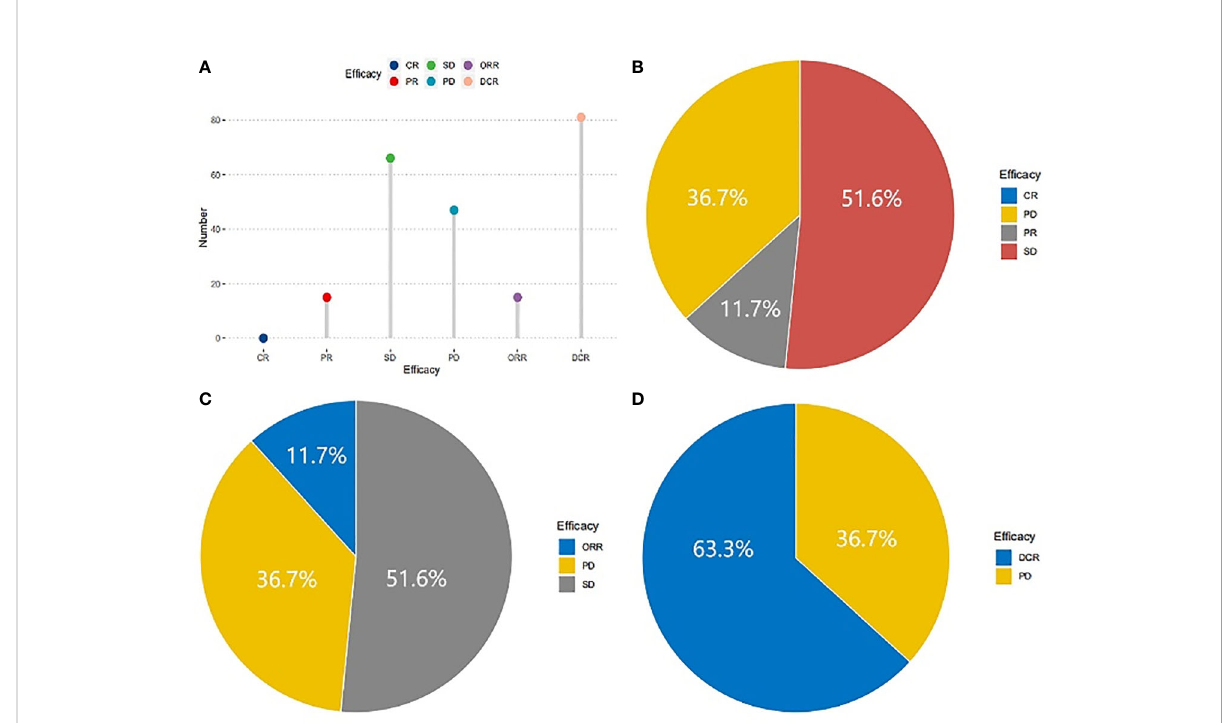
FIGURE 1 Short-term ef fi cacy of patients in NSCLC treated with Apatinib. No patient with CR, 15 patients with PR, 66 patients with SD and 47 with PD (A) , the proportions were 0, 36.7%, 11.7%, 51.6% respectively (B) . The ORR was 11.7% (C) and DCR was 63.3% (D) .